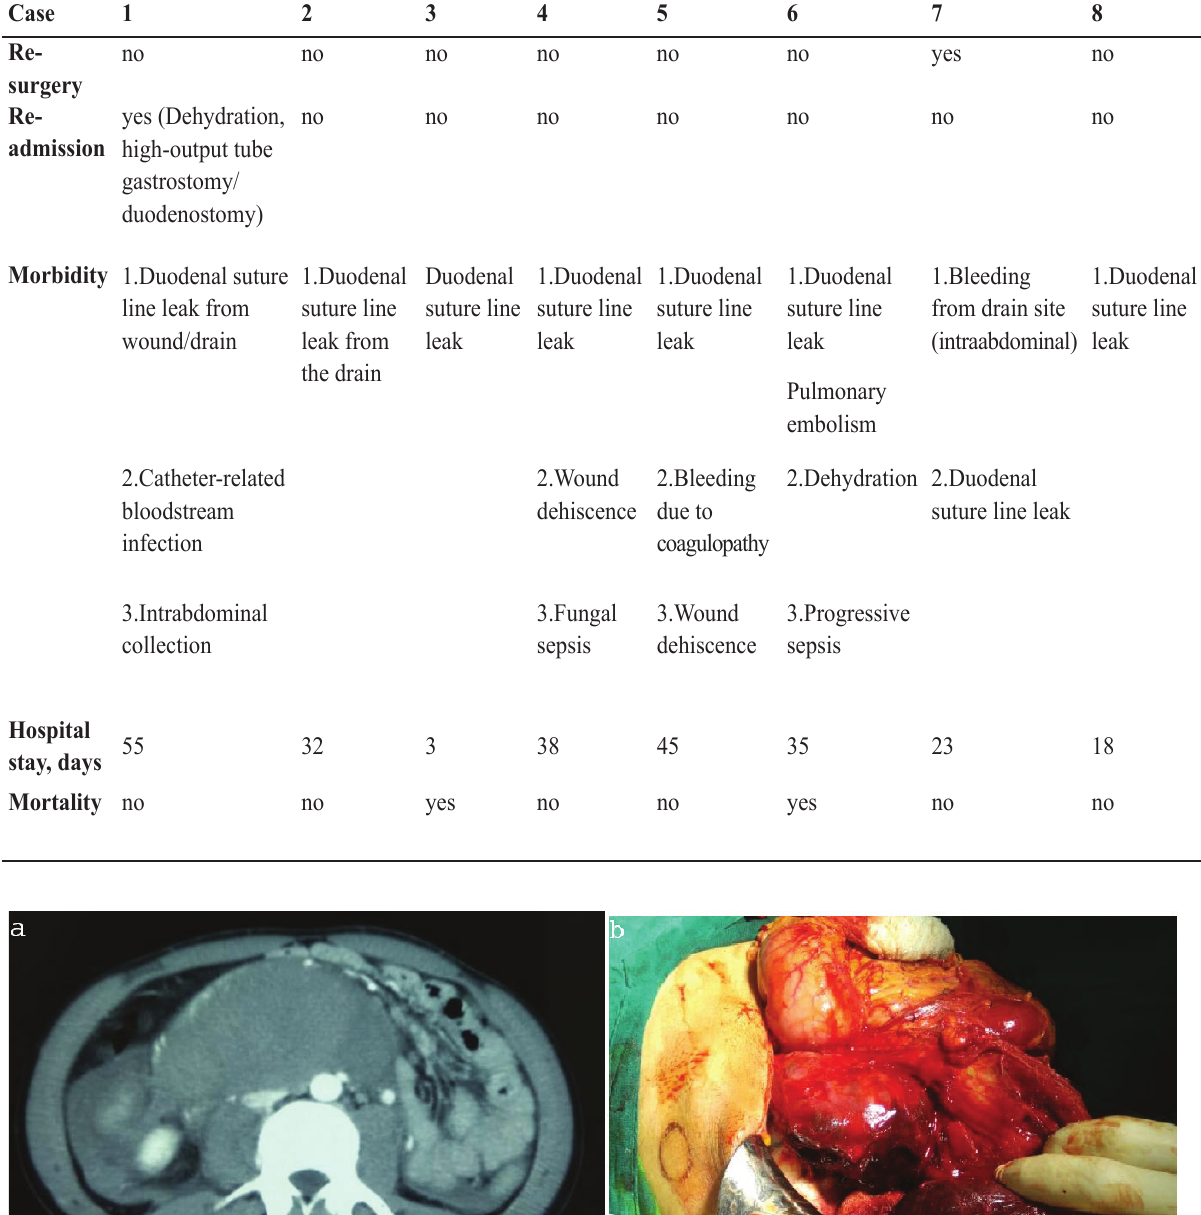
Table 2: Surgery and postoperative outcome of the patients with duodenal injury Case